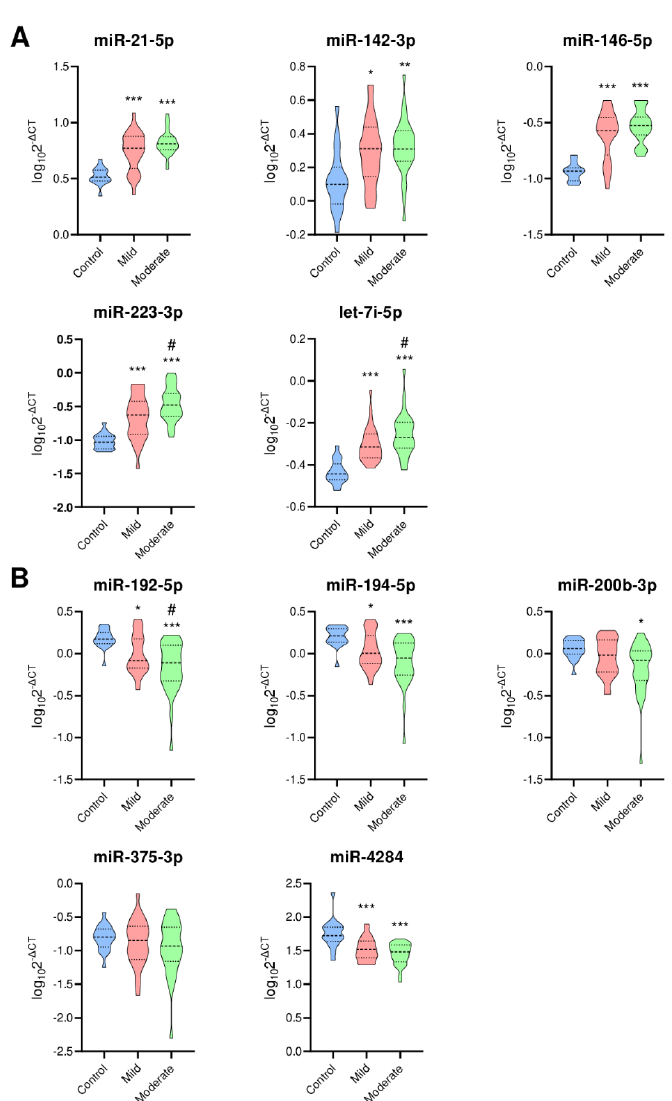
Figure 1. Expression of selected 10 miRNAs. ( A ) Upregulated miRNAs; ( B ) Downregulated miRNAs. Violin plots indicating expression of each miRNA. Blue, red and green violins indicate controls, mild UC patients and moderate UC patients, respectively. Thick dotted line, median; thin dotted line 25% and 75% quartiles. Y-axis is defined as log10(2- ∆ CT). * p < 0.01, ** p < 0.001, *** p < 0.0001 versus control, # p < 0.05 versus mild UC patient.